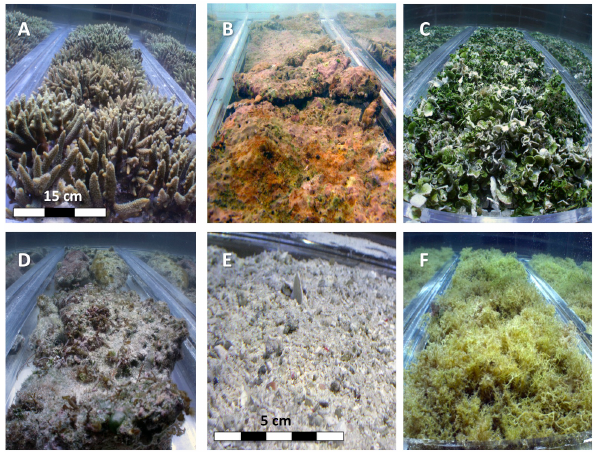
Fig. 3. Flume assemblages of six benthic groups from the Heron reef flat environment. (A) branching coral, Acropora aspera ; (B) Crustose coralline algae (CCA) dominated by Porolithon onkodes ; (C) calcifying macroalgae, Halimeda cuneata f. undulata ; (D) turf assemblage consisting of a mixture of cropped algae, benthic mi- croalgae and fine sand; (E) close-up of sand community domi- nated by a grain size of 0.5–2mm; and (F) fleshy macroalgae (Chnoospora implexa ).